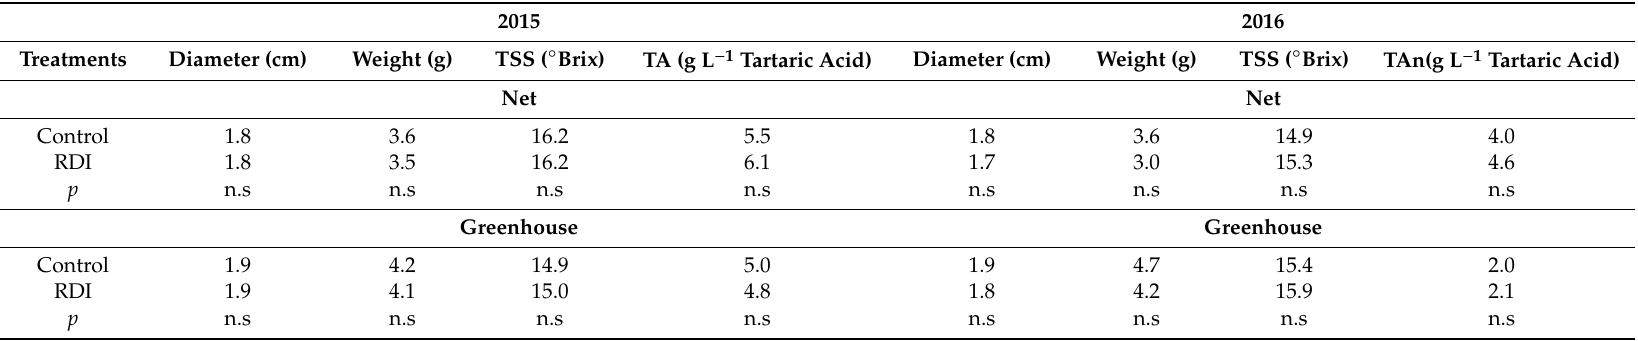
Table 5. Berry quality parameters in the most representative picking operation in response to irrigation treatments (Control and regulated deficit irrigation (RDI)) in vines grown under net and plastic greenhouse in 2015 and 2016. (n.s.: nonsignificant, Student’s t test p < 0.05)